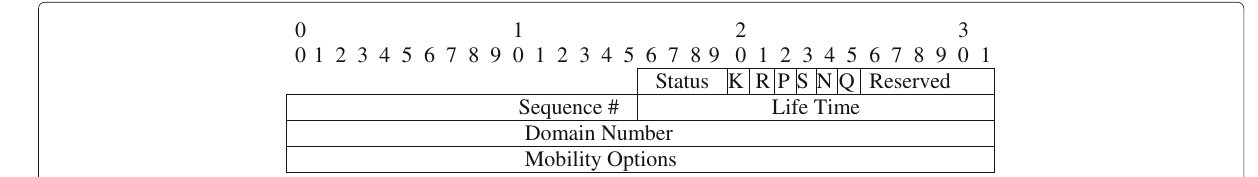
Fig. 9 LPBA message, including the domain